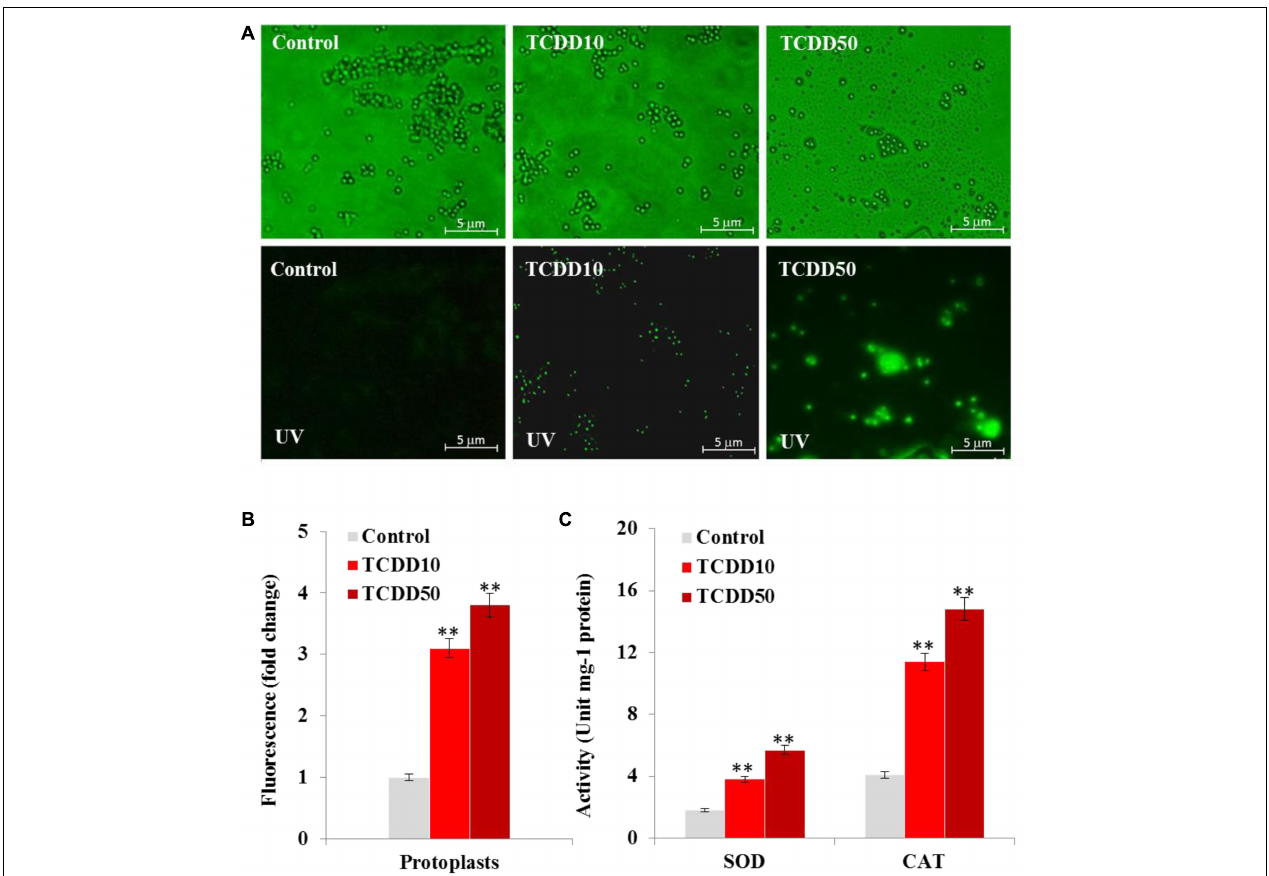
FIGURE 2 | The exposure to TCDD enhances the accumulation of ROS in fungal tissues. (A) Micrographs of fungal spore protoplasts stained with DCFH-DA, a cell-permeable non-fluorescent probe that turns to highly fluorescent 2 (cid:48) ,7 (cid:48) -dichlorofluorescein in the presence of cellular ROS. Samples were examined under a Nikon Eclipse Ti-U fluorescent microscope and micrographs recorded at a magnification of 10 × a using a Nikon Ti-U camera. Bar represents 5 µ m. (B) The ROS fluorescence intensity was analyzed by software Image-Pro Plus 6.0. The fold change in fluorescence intensity was estimated by comparing the TCDD-treated samples for spore protoplasts with their respective controls that were considered as 1. Data were shown as the mean ± SD . (C) Enzymatic activities of SOD and CAT in fungal tissues in response to TCDD exposure at indicated concentrations. All measurements were done in triplicate and the presented data are means ± SD ( n = 3). Difference between treatments and control was significant ( ∗ P < 0.05) or very significant ( ∗∗ P < 0.01) when analyzed by t